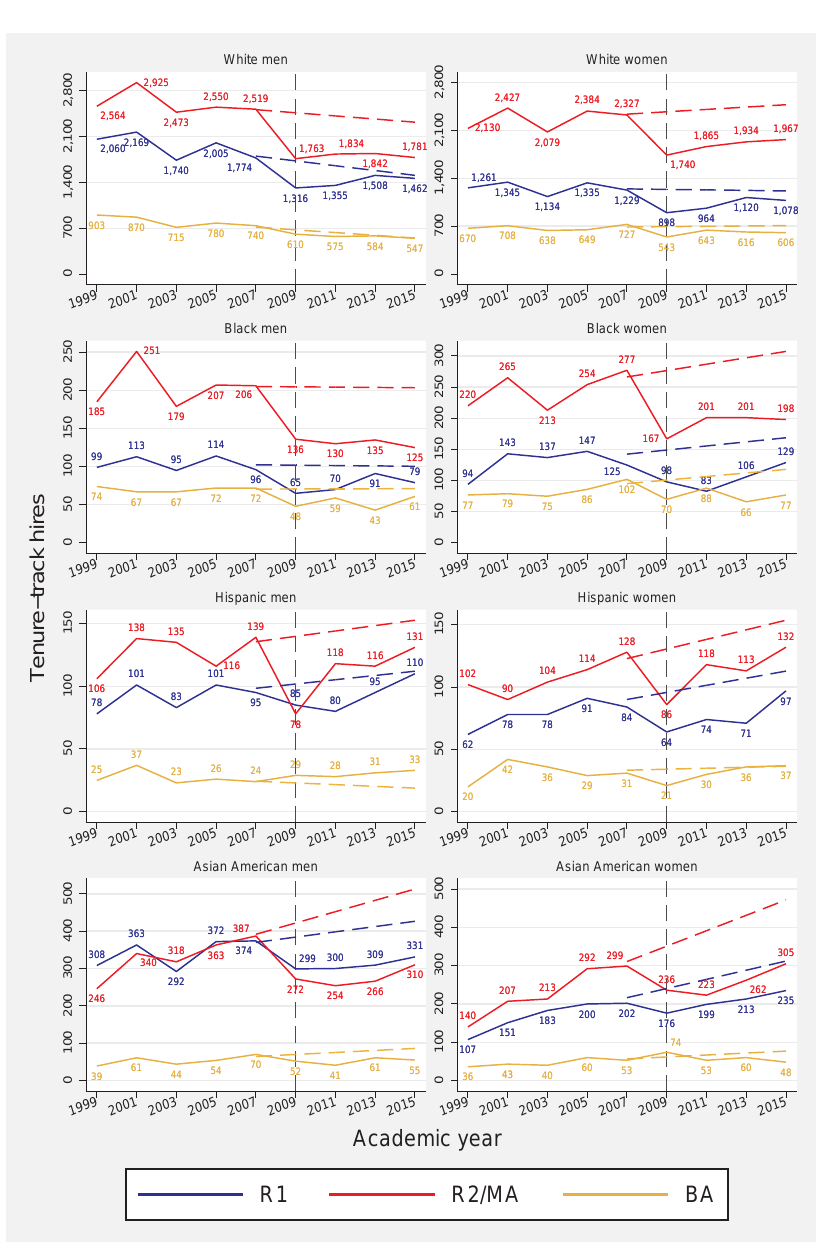
Figure 5: Tenure-track hires by demographic group and Carnegie group. Dotted lines extend pre-recession (1999 to 2015) trends based on bivariate regression estimates.